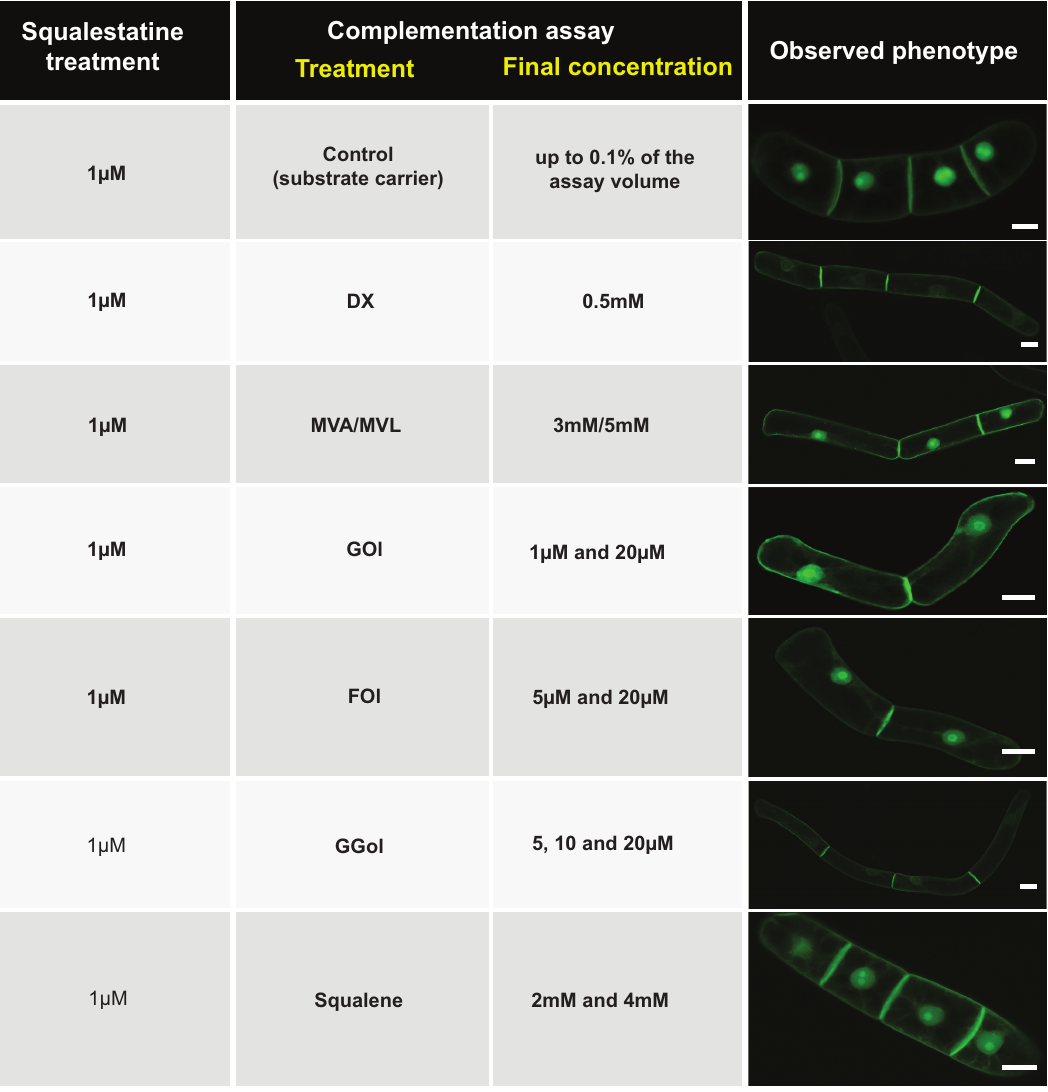
Figure 2. Chemical complementation of squalestatin-induced H -GFP-BD-CVIL mislocalization. Squalestatin was added at 6 1µM throughout the series of experiments. Partial delocalization (from the PM to the nucleus/nucleolus) with pathway intermediates, isoprenols and squalene in an attempt to chemically complement the effect of squalestatin. MVA: mevalonic acid; MVL: mevalonolactone; DX: 1-deoxyxylulose; Gol: geraniol; Fol: farnesol; GGol: geranylgeraniol. White bars =